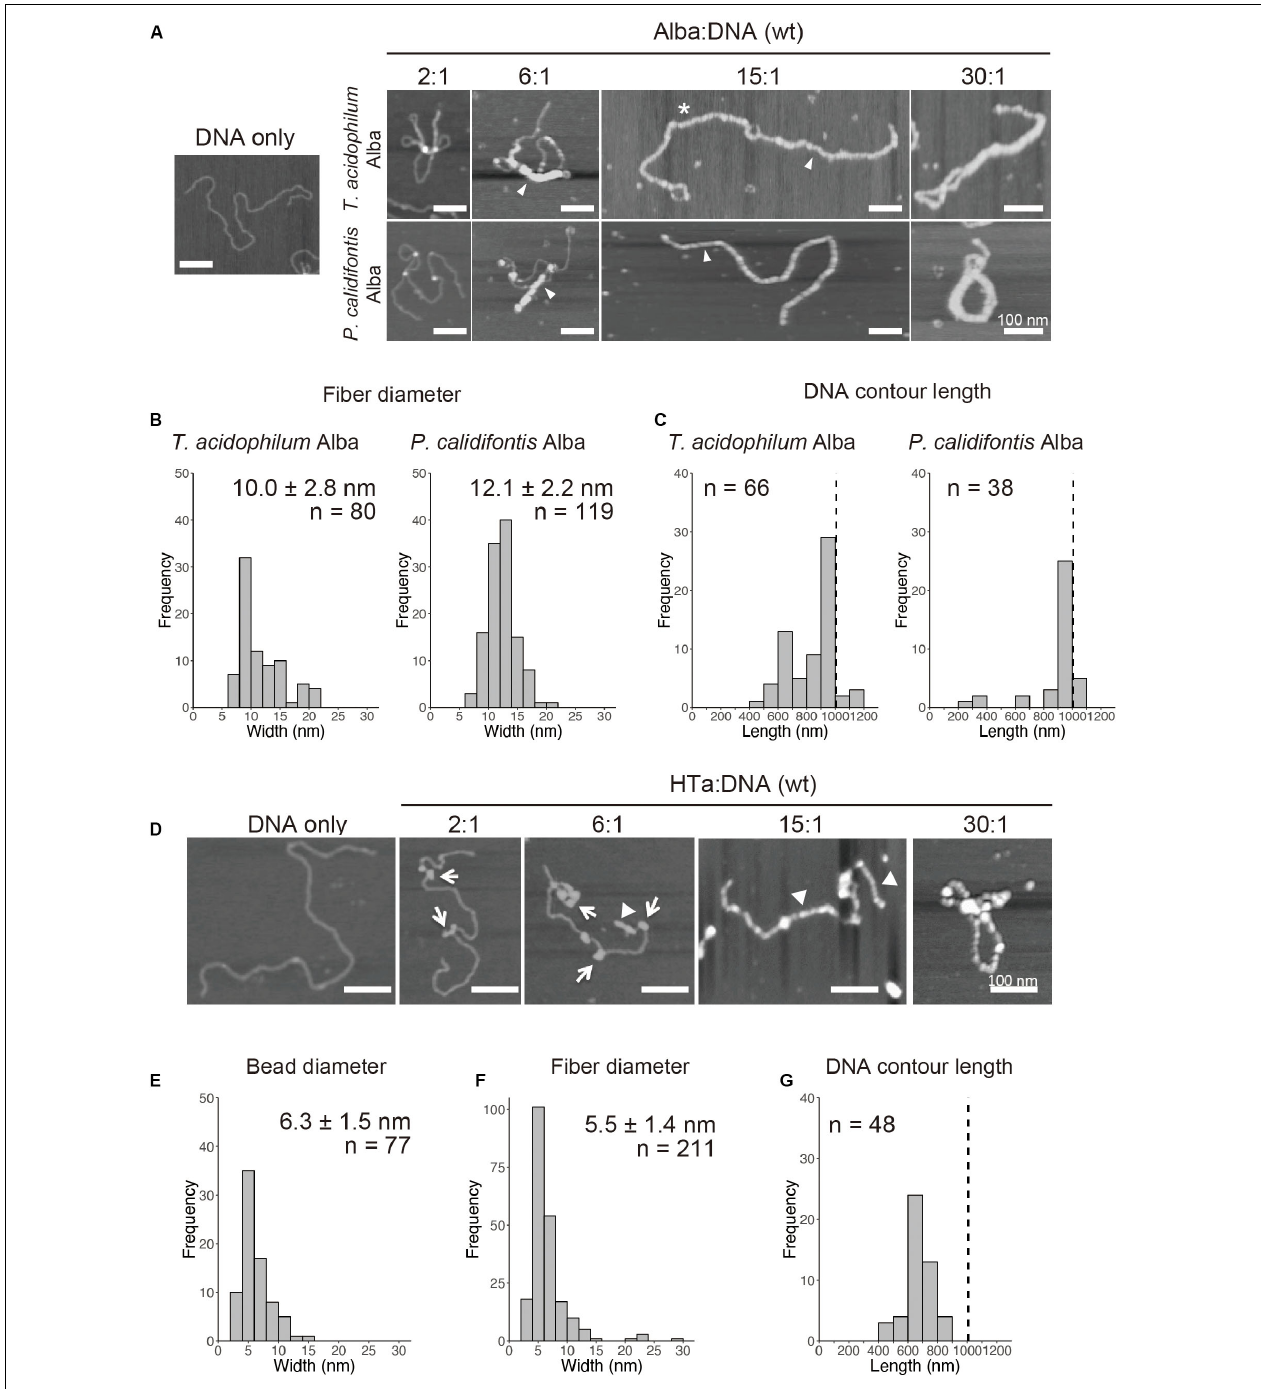
FIGURE 5 | In vitro reconstitution of chromosome structures with recombinant Alba and HTa. (A–C) Reconstitution on a linear 3-kb plasmid using recombinant Alba from T. acidophilum and P. calidifontis at different Alba to DNA weight ratios. (A) AFM images showing various structures formed with Alba and DNA. Fibers are indicated with arrow heads. Alba:DNA weight ratios are indicated. The asterisk indicates a structure in which two 3-kb DNA molecules are joined together by Alba binding. (B) Histograms show the diameters of the fibrous structures formed (indicated with arrow heads in A ). (C) Histograms show the respective contour lengths of DNA at a 15:1 Alba:DNA ratio. The theoretical length of a linear 3-kb DNA ( ∼ 1000 nm) is indicated with a dashed line. See Figure 6A for a histogram of unbound DNA length. (D–G) Reconstitution with histidine-tagged HTa from T. acidophilum at varying protein to DNA ratio. (D) AFM images showing beaded (arrows) and filamentous (arrow heads) structures. (E) Diameter of the beads formed at a relatively lower HTa concentration. (F) Width of the filaments formed at relatively higher HTa concentration. (G) Histogram shows the contour DNA lengths of the structures formed at a 15:1 HTa:DNA ratio. Dashed line indicates the theoretical length of a 3-kb unbound DNA. Scale bars: 100